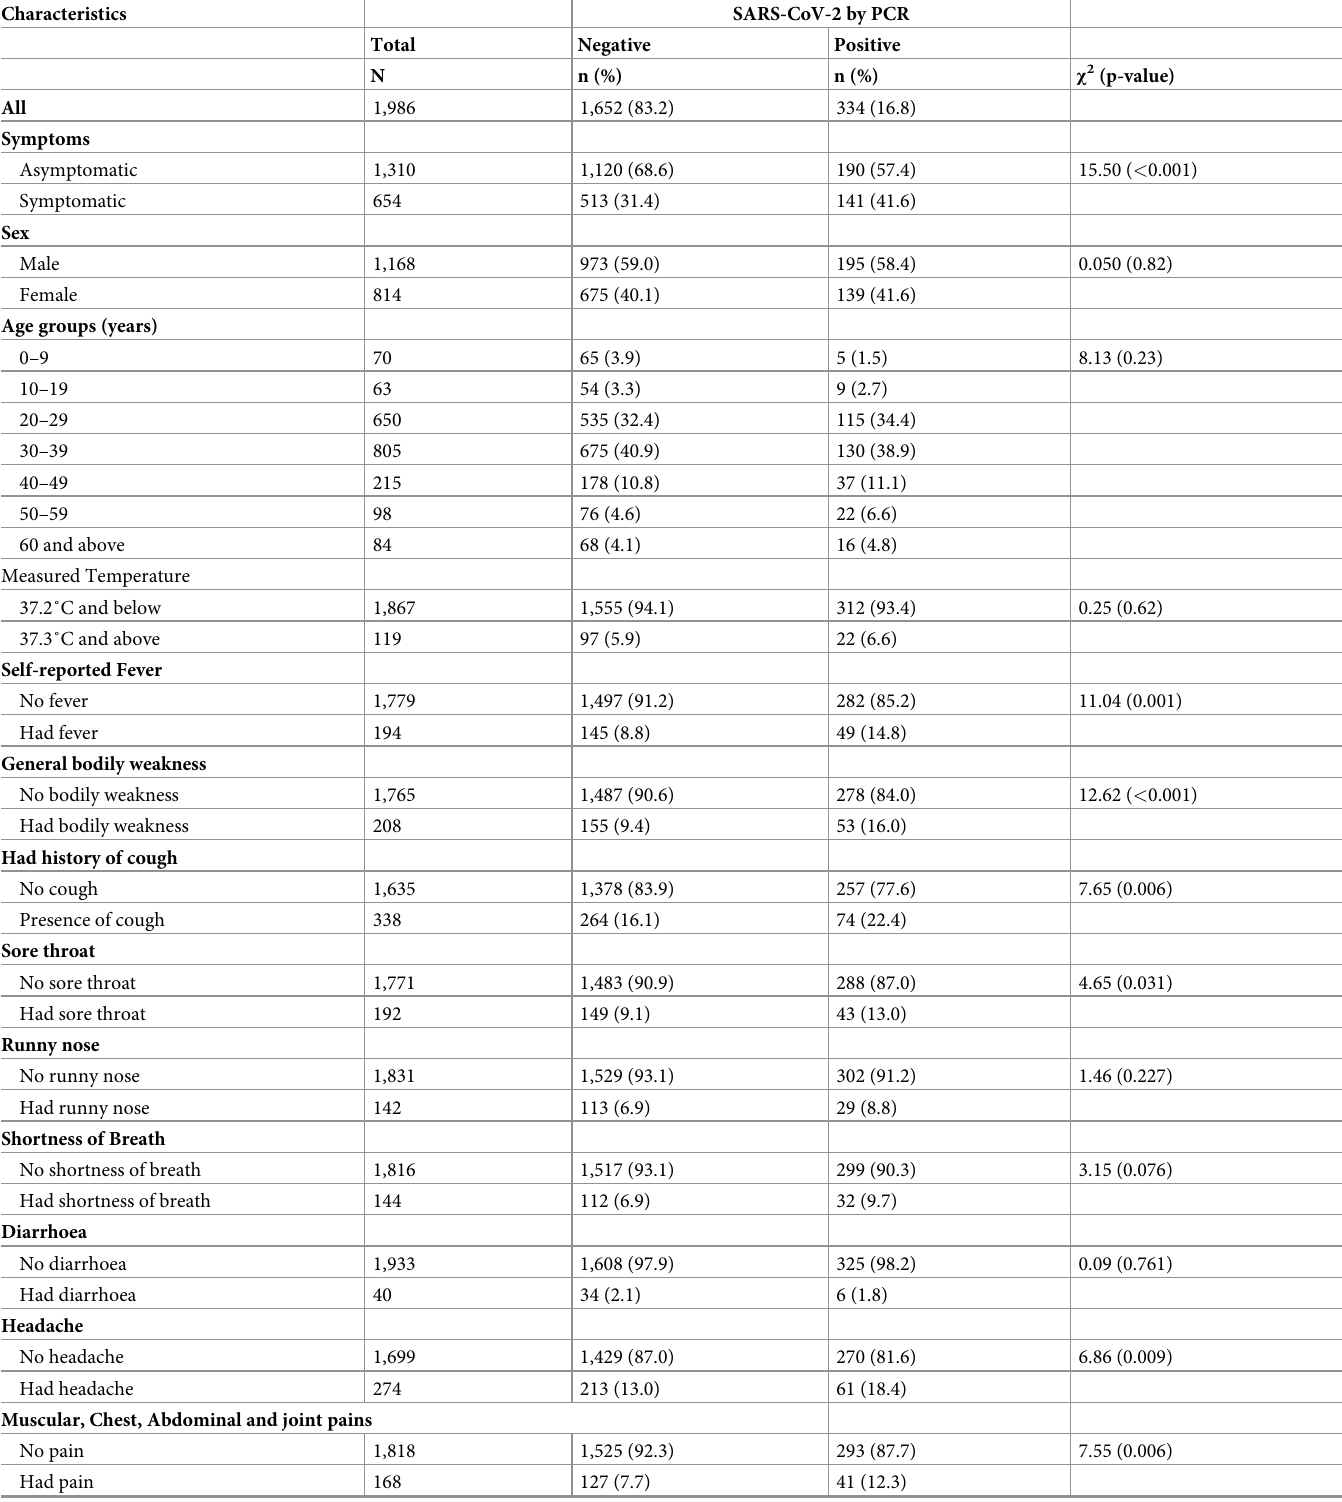
Table 1. Background characteristics of study